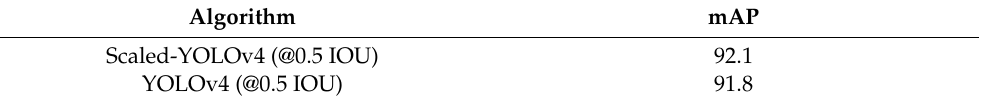
Table 6. Comparison of mAP on best-performed Scaled-YOLOv4 vs. YOLOv4 [7].